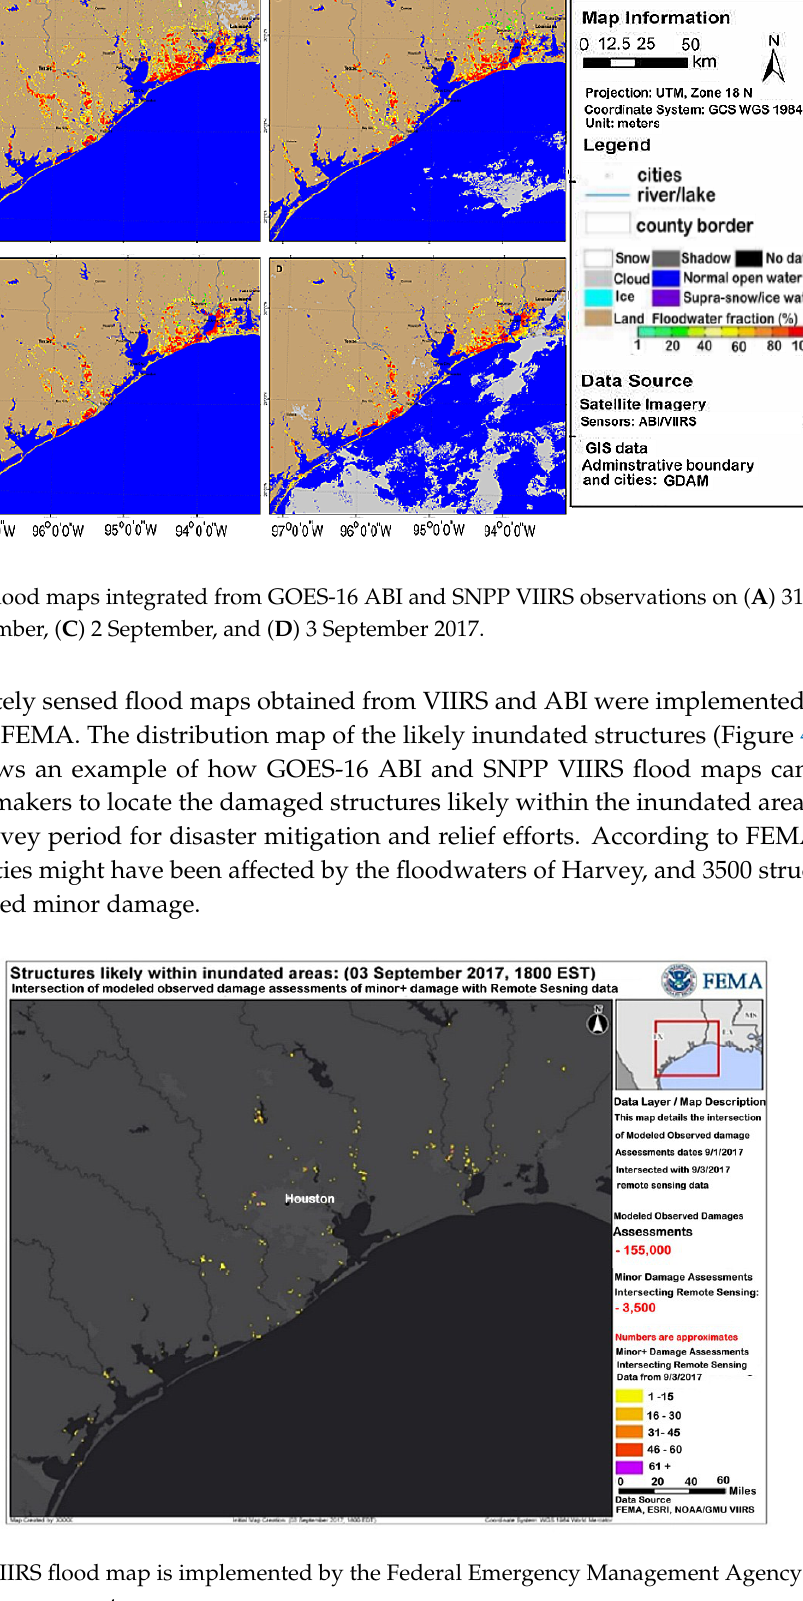
Figure 4. VIIRS flood map is implemented by the Federal Emergency Management Agency (FEMA) for damage assessment.